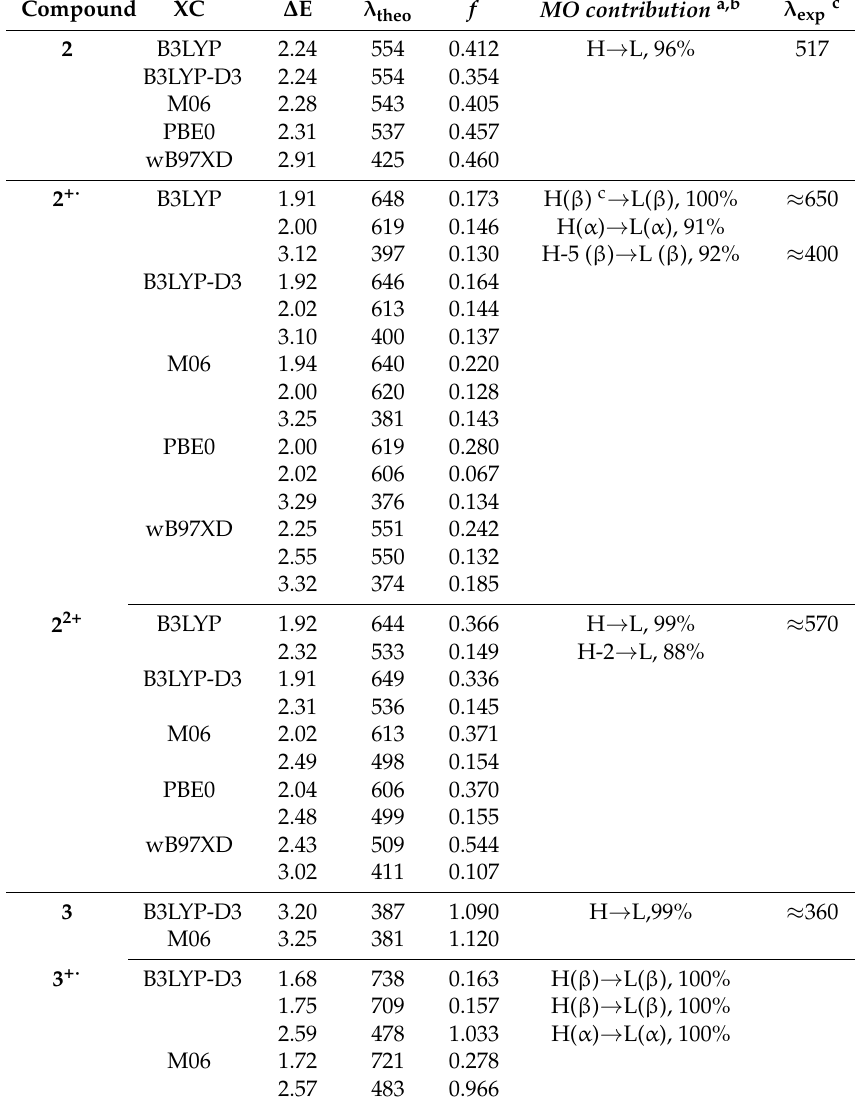
Table 3. Vertical excitation energies, ∆ E in eV, absorption wavelengths, λ theo in nm, and oscillator strength, f , computed in dichloromethane for systems 2 and 3 employing different exchange–correlation functionals. The main Molecular Orbital contributions (%) for each absorption band computed at B3LYP/6-31+G* are